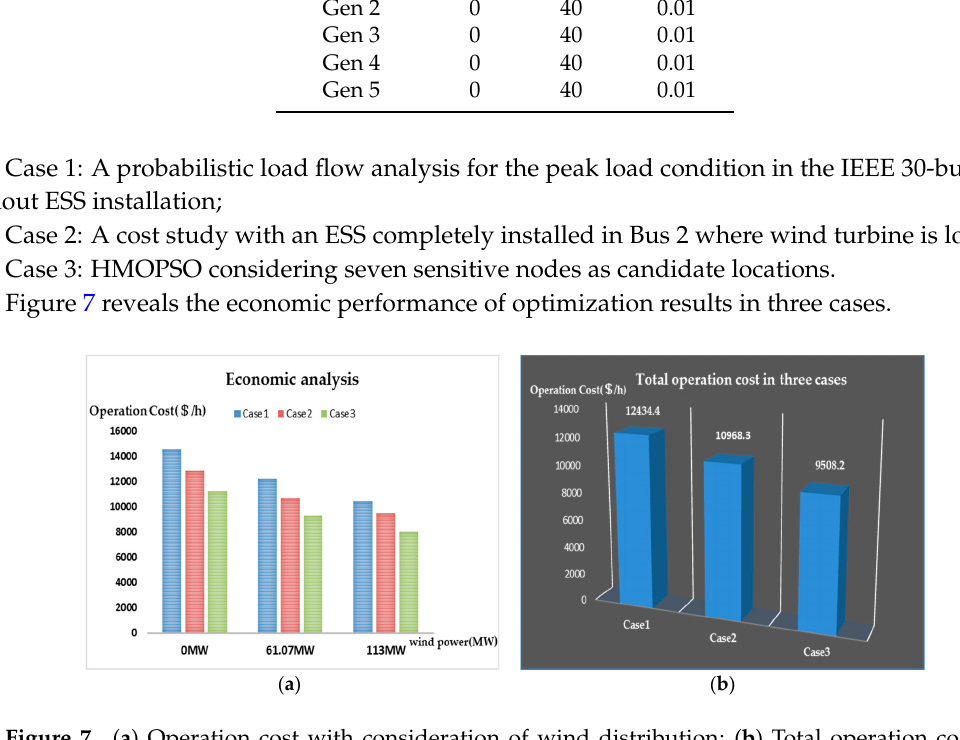
Table 2. Fuel cost parameters of diesel engines.